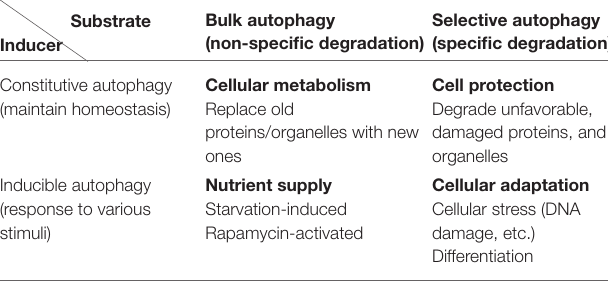
TABLE 1 | Classification of autophagy from the view of inducers and substrates. Selective autophagy Substrate Bulk autophagy (non-specific degradation) (specific degradation) Inducer Constitutive autophagy (maintain